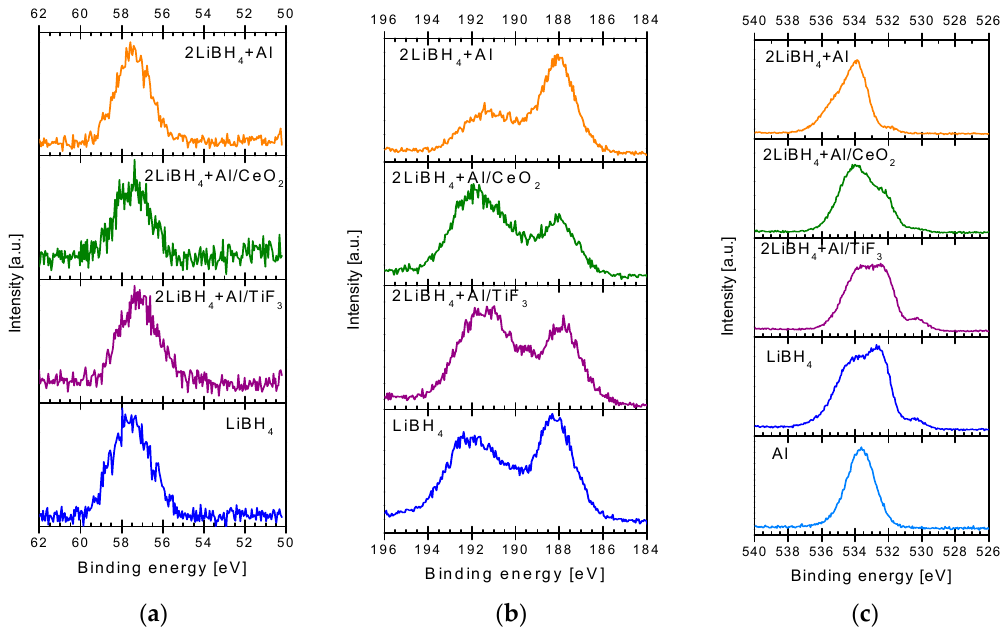
Figure 3. X-ray photoelectron spectroscopy (XPS) spectra of as-milled 2LiBH 4 + Al, 2LiBH4 + Al/TiF 3, and 2LiBH 4 /CeO 2 . ( a ) Li 1s edge; ( b ) B 1s edge; ( c ) O 1s edge.